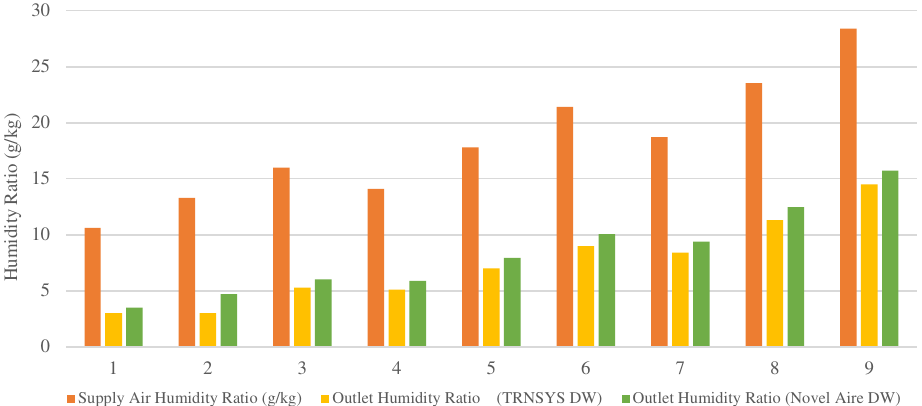
Figure 8. Comparison of the process air outlet humidity ratios for the DDW from the TRNSYS model and Novel Aire simulation software.